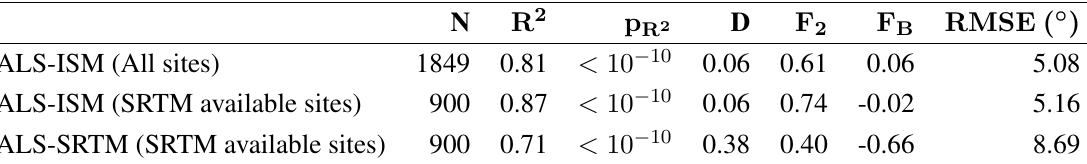
= fractional probability R 2 = fraction of 2 = fractional bias, and RMSE = root B